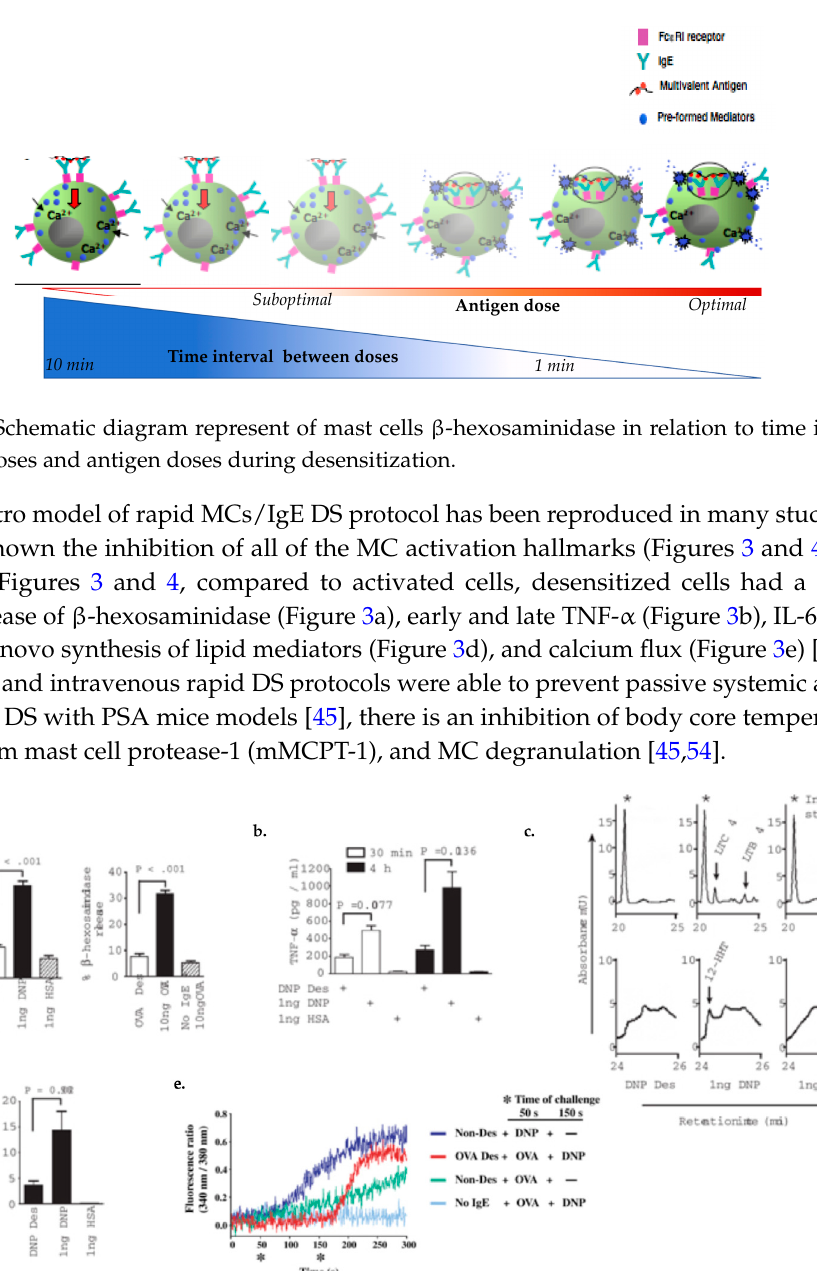
Figure 3. Mast cell IgE/Antigen desensitization inhibits the pre-formed mediators release, lipid mediators and cytokine production, and calcium flux and is antigen specific. 1. Pre-formed mediators release: ( a ) beta-hexosaminidase release: MCs desensitized to DNP-HAS and OVA showed a 78% and 71% reduction of beta-hexosaminidase release, respectively compared to activated MCs with same allergen. ( b ) Pre-formed TNF-(white bars) and de novo synthesized TNF-(black bars) have a 62% and 75% reduction after desensitization, respectively compared with activation. 2. Lipid mediators production: ( c ) Arachidonic metabolites represent by Cysteinyl leukotriene C4 (LTC4), leukotriene B4 (LTB4), and 12(s)-hydroxyheptadeca-5Z, 8E, 10E-trienoic acid (12-HHT) were detected in MC supernatant after activation but not in control or desensitized MCs. 3. Cytokines production: ( d ) During DS, IL-6 production is 75% less than during activation. 4. calcium flux: ( e ) Calcium flux is impaired in OVA desensitized MCs after being triggered with activating dose of OVA but the influx is restored by activating with DNP-HAS non-desensitizing antigen (red line). Adapted from Sancho-Serra, et al., 2011 [53] with permission from John Wiley and Sons.